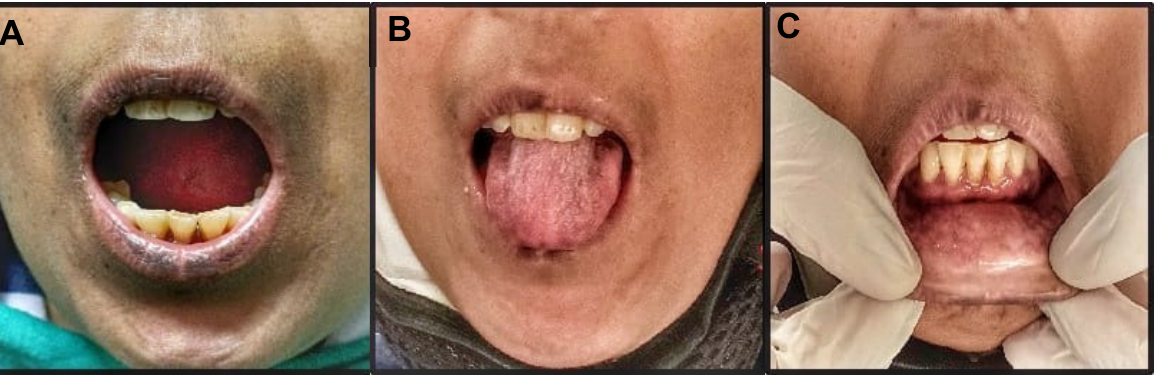
Figure 2. ( A )—Reduced mouth opening, ( B )—depapillated tongue with restricted protrusion, ( C )—mild gingival recession and fibrotic labial mucosa.